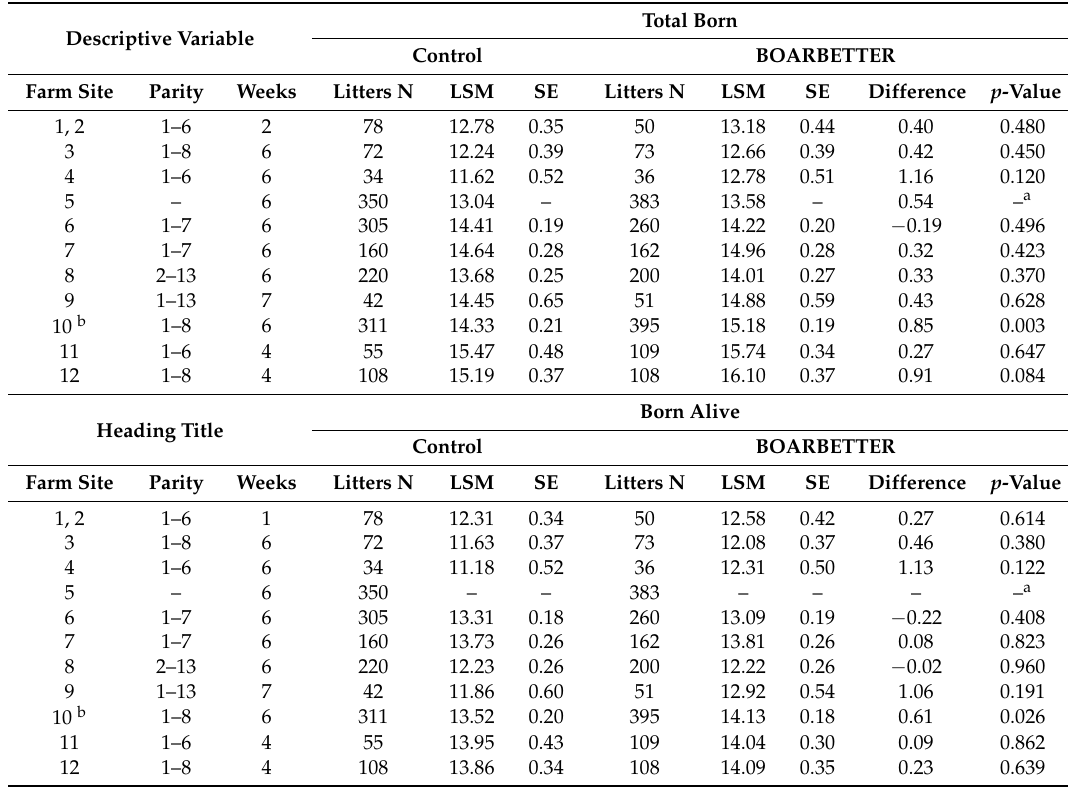
Table 3. Least squares means (LSM) for Total Born (TB) and Born Alive (BA) by farm site. The p -values listed are the within-farm P-values. The averages of these values are presented in Table 2. Data from most farms lack sufficient power to detect differences; see Table 4 for the merged dataset that contains sufficient statistical